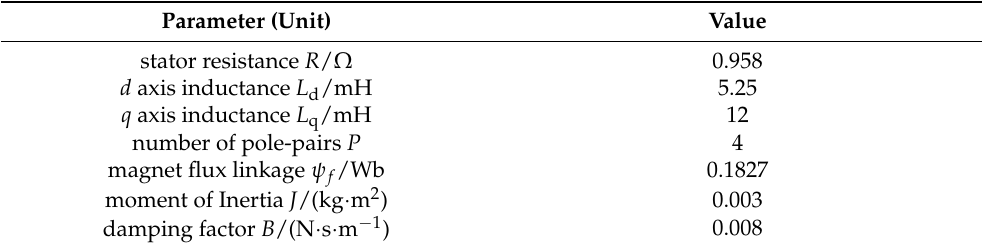
Table 1. IPMSM Table 1. IPMSM parameters.